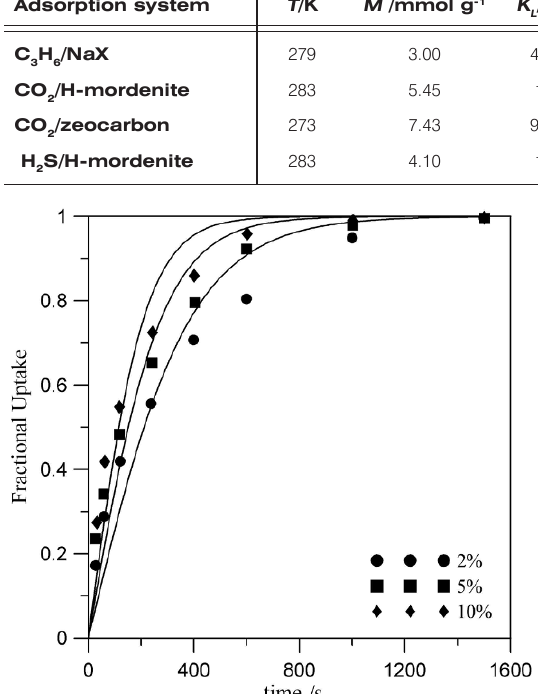
Figure 6. Comparison of the experimental kinetic isotherms for the C H /Ajax AC adsorption at 303 K measured by 3 8 Qiao and Hu [15] with the theoretical isotherms (solid lines) calculated from Eq. 10 by accepting the values of parameters collected in Table 2.